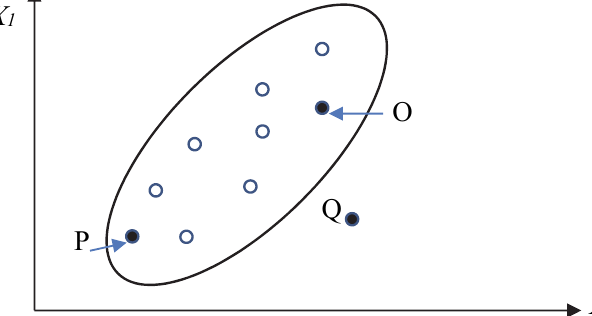
Fig. 1. Correlated attributes with unequal